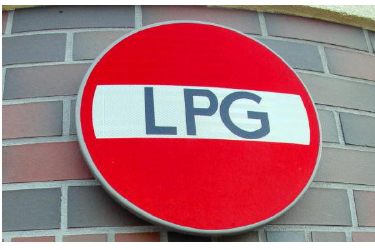
Fig. 11. A sign prohibiting entry for a vehicle powered by LPG In Polish law, the document regulating the